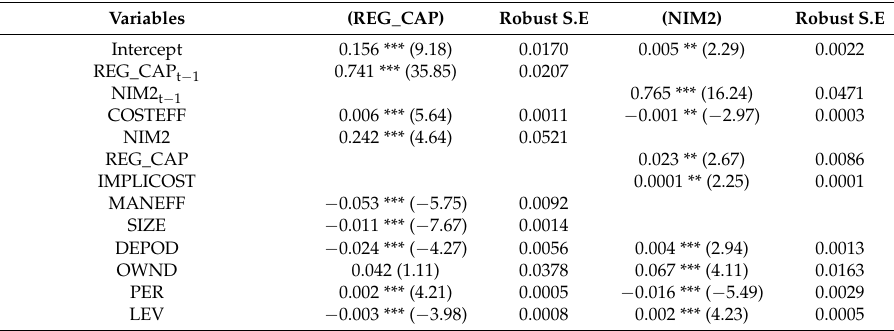
Table 5. Determinants of Capital Ratio and Banks’ Intermediation